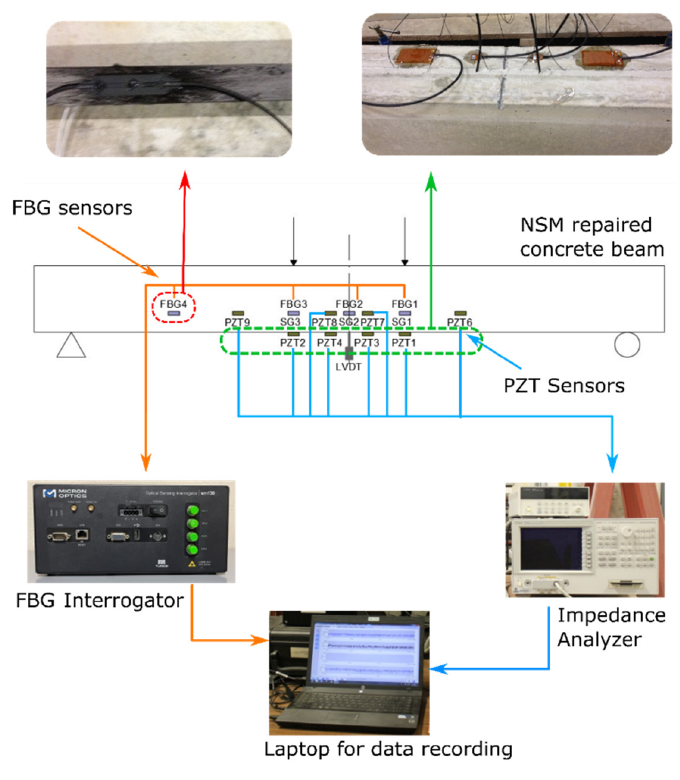
Figure 3. Experimental setup.